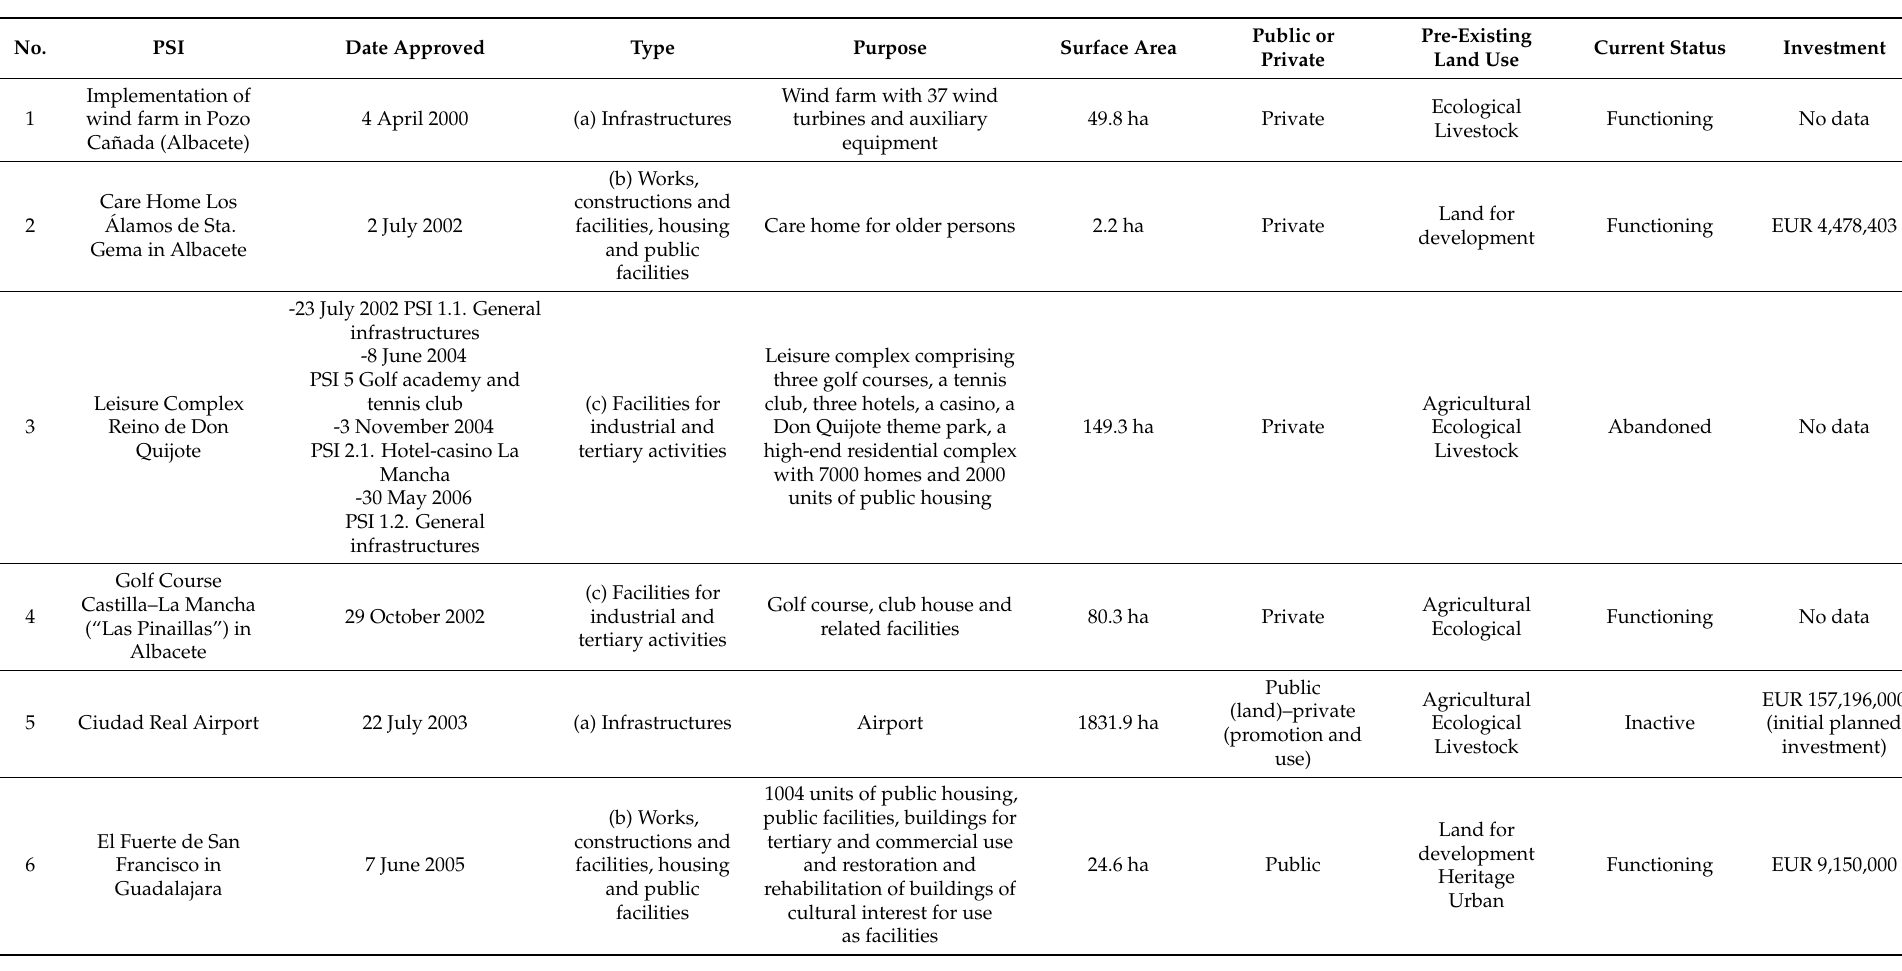
Table 1. Projects of Special Interest in Castilla–La Mancha. Source: own preparation using available documentation